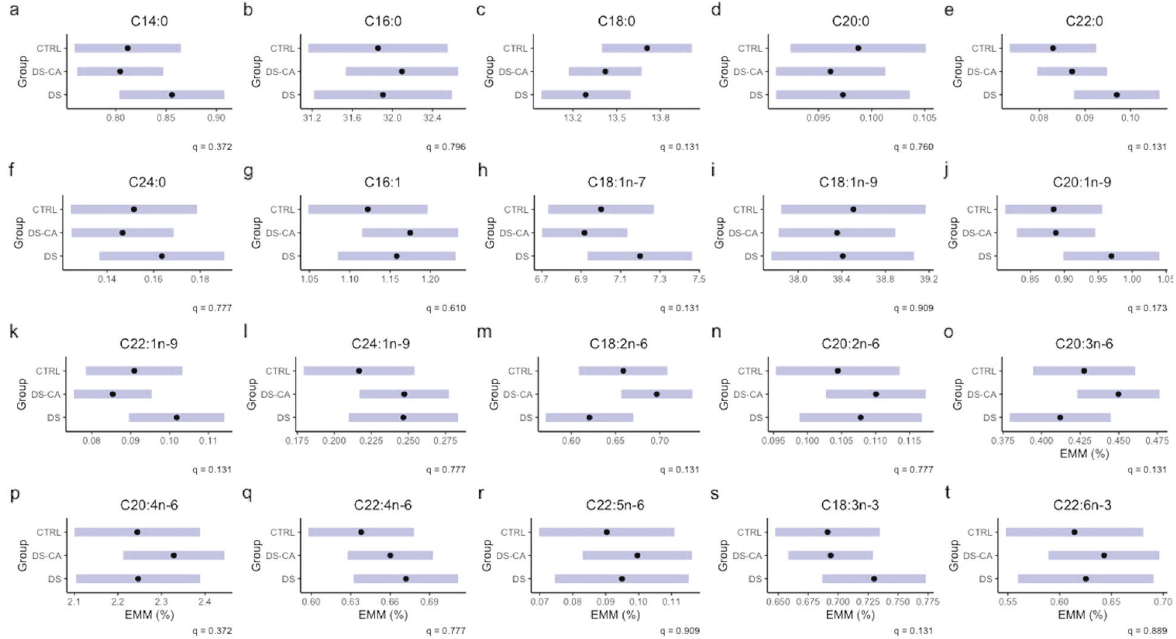
Fig. 3 Relative percentage of fatty acids in choline glycerophospholipids between groups. Black dots represent the estimated marginal means for group and the purple bars represent the 95% con fi dence intervals based on linear models for the relative percentage of FA as a function of the group with Age, PMI, pH, and sex as covariates. The group term did not reach signi fi cance in any relative percentage model after correction for multiple